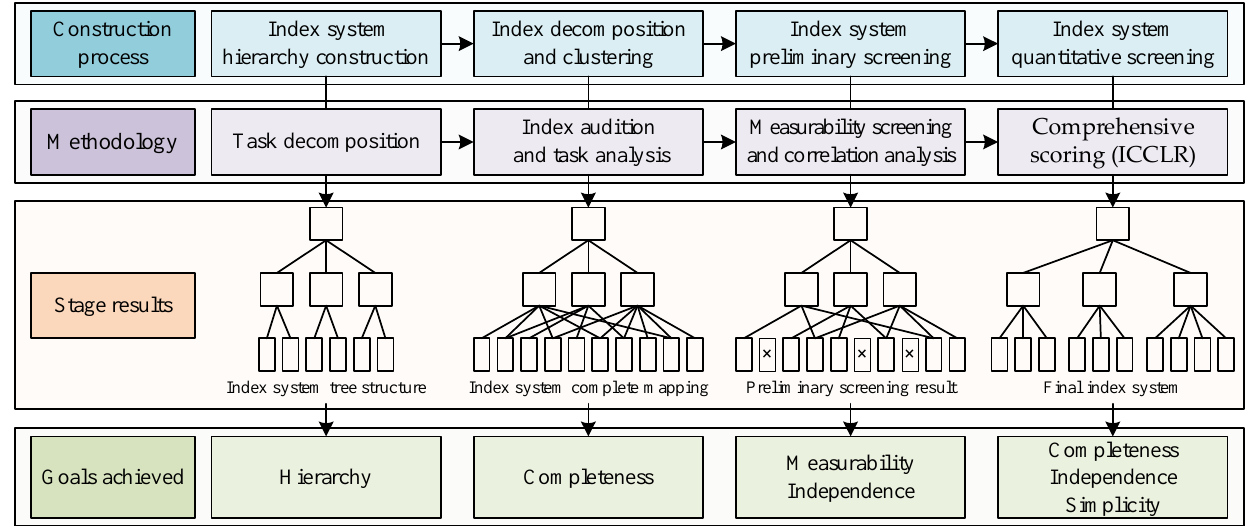
Figure 2. Index system construction process.